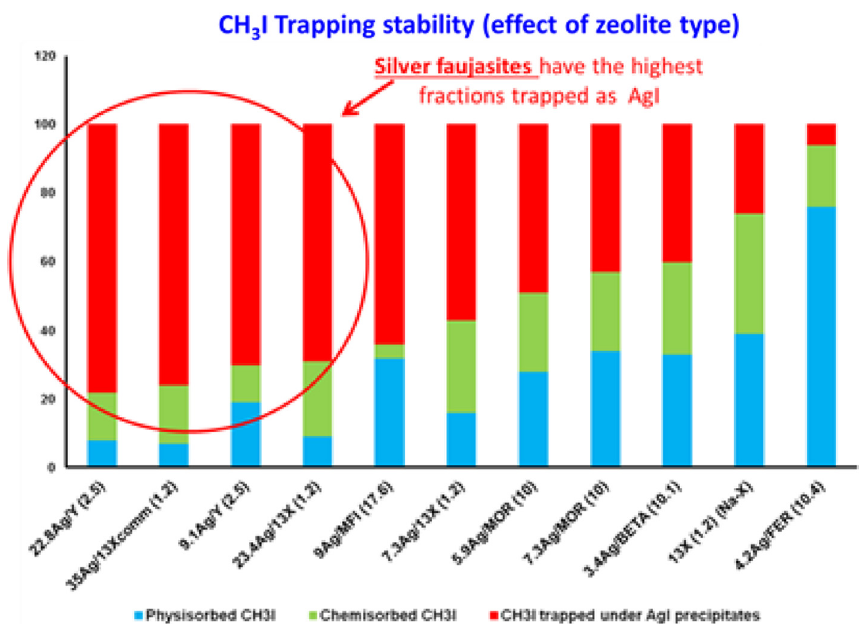
Fig. 6. Example of PASSAM results on zeolite retention capability ( © University of Lorraine, 2016).